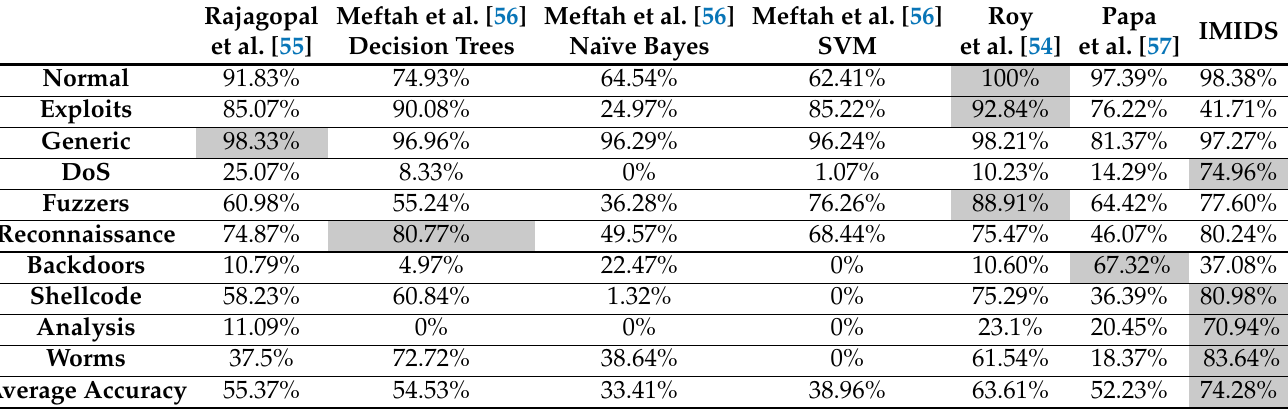
Table 3. Comparing the attack classification accuracy between IMIDS and recent articles.